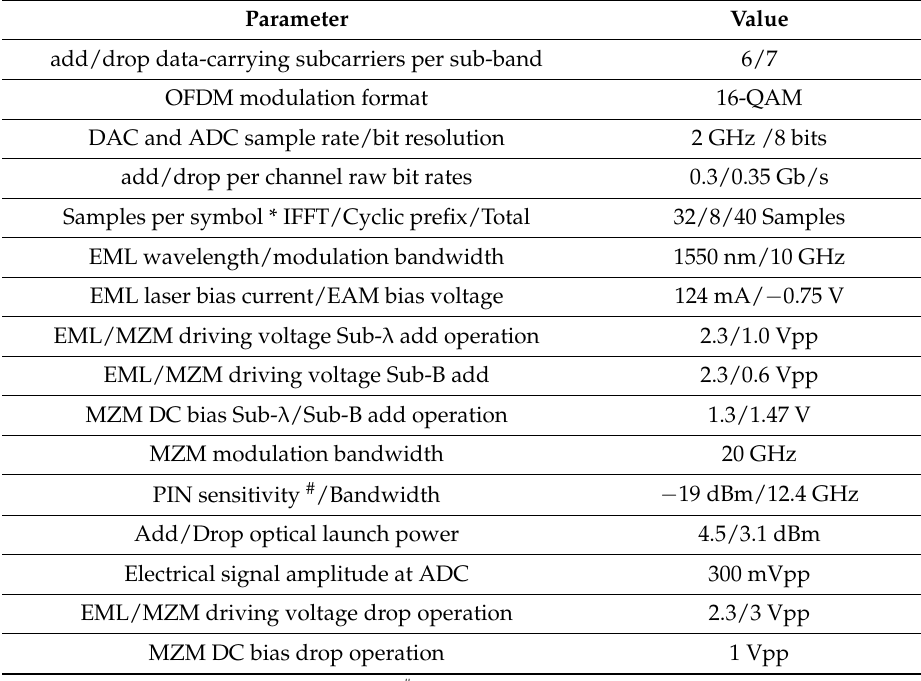
Table 2. Transceiver and system